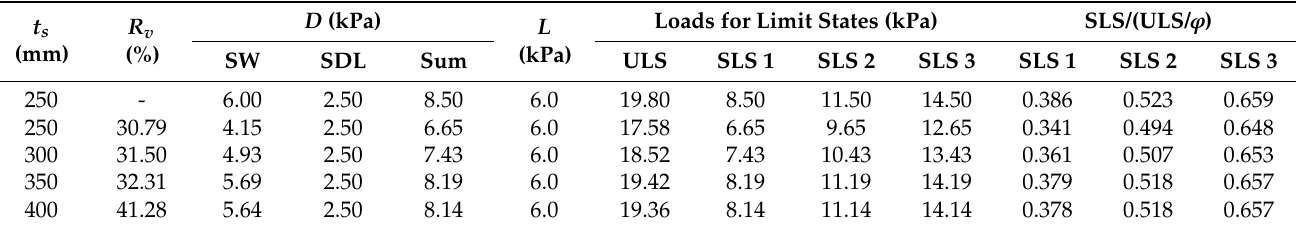
Table 2. Serviceability limit states (SLS) for deflection